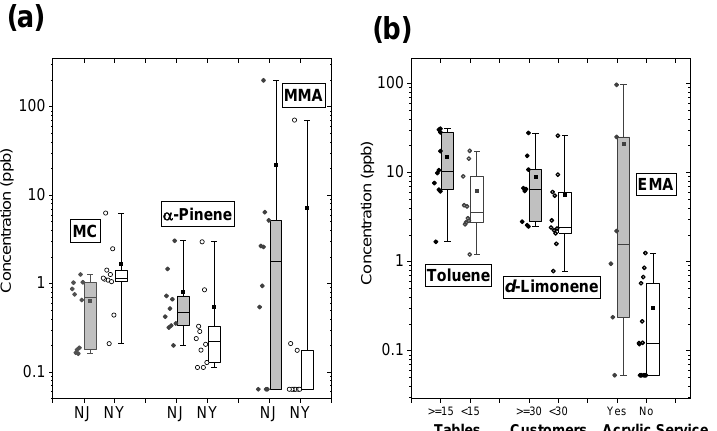
Figure 3. Box plots for comparison of VOCs and phthalates by sampling locations and selected nail salon characteristics. ( a ) shows the comparison of methylene chloride (MC), α -pinene, and methyl methacrylate (MMA). ( b ) compares the differences of toluene by the number of manicure and pedicure tables, d-limonene by average daily customers, and the comparison of ethyl methacrylate (EMA) by acrylic nail service.